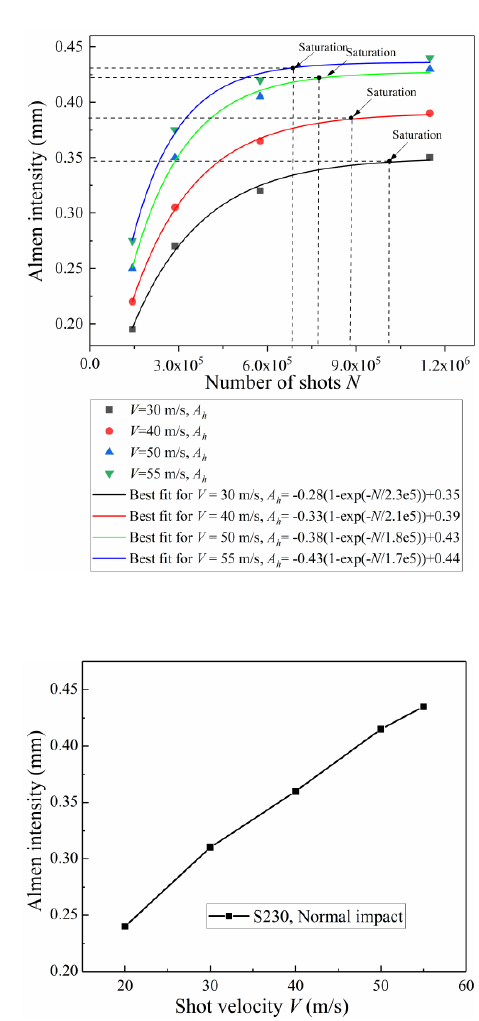
Figure 15. Simulation of the Almen intensity test. ( a ) Saturation curves of Almen strips with different shot velocities, corresponding to impingement angle θ = 90 ◦ . ( b ) The relationship between the Almen intensity and shot velocity.